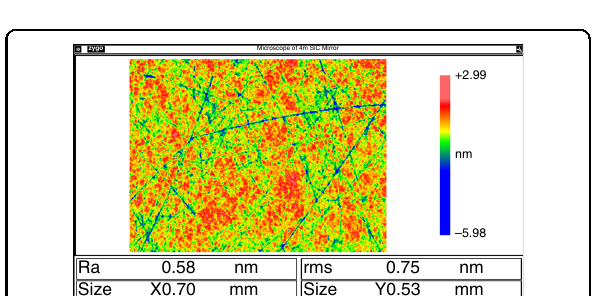
Fig. 11 Roughness testing results of the cladding layer after polishing. Surface roughness of the Si cladding layer is polished to